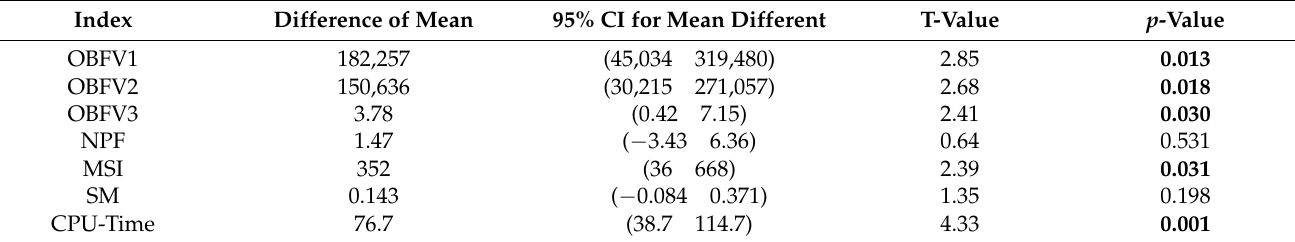
Table 14. Results of t -test.